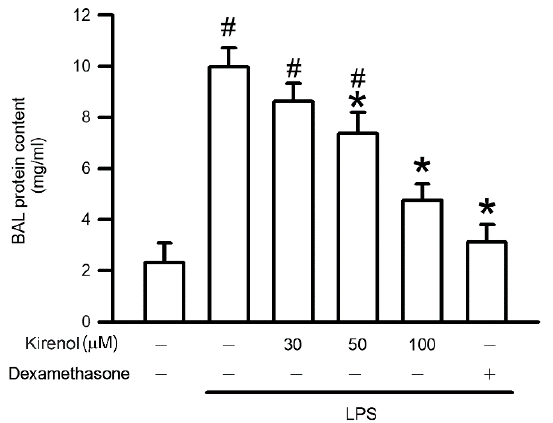
Figure 2. Kirenol protected against LPS-induced alveolar-capillary barrier disruption. The contents of protein in bronchoalveolar lavage fluid (BALF) were measured by Bradford protein analysis. Values are shown the mean ± S.D. of 3–4 mice per group. # represents the significant difference compared with the Group I ( p < 0.05); * represents the significant difference compared with the Group II ( p <